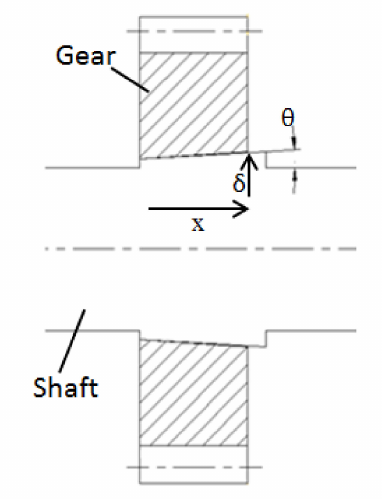
Figure 6. Relationship between pulling up x and interference δ